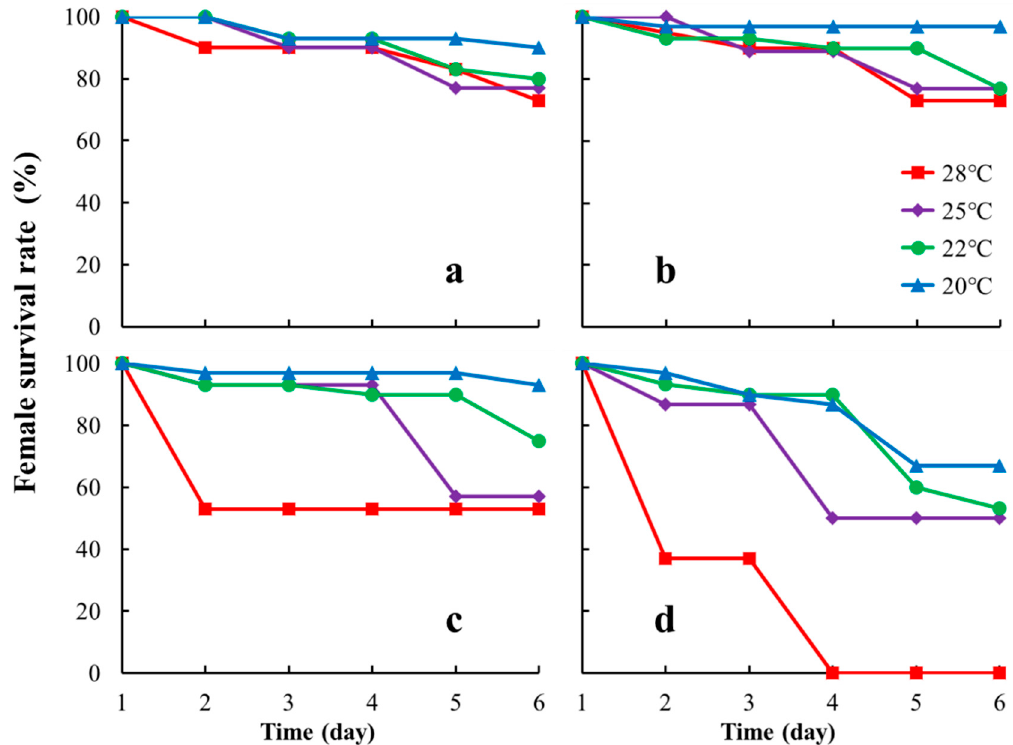
Figure 3. Female survival rates of Acartia bifilosa under different seawater temperatures (20, 22, 25, and 28 °C) and Chl a concentrations ( a ): 15 μ g/L, ( b ): 10 μ g/L, ( c ): 5 μ g/L, ( d ): 0 μ g/L.